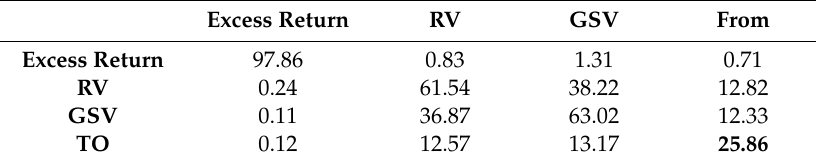
Table 13. Total spillover,